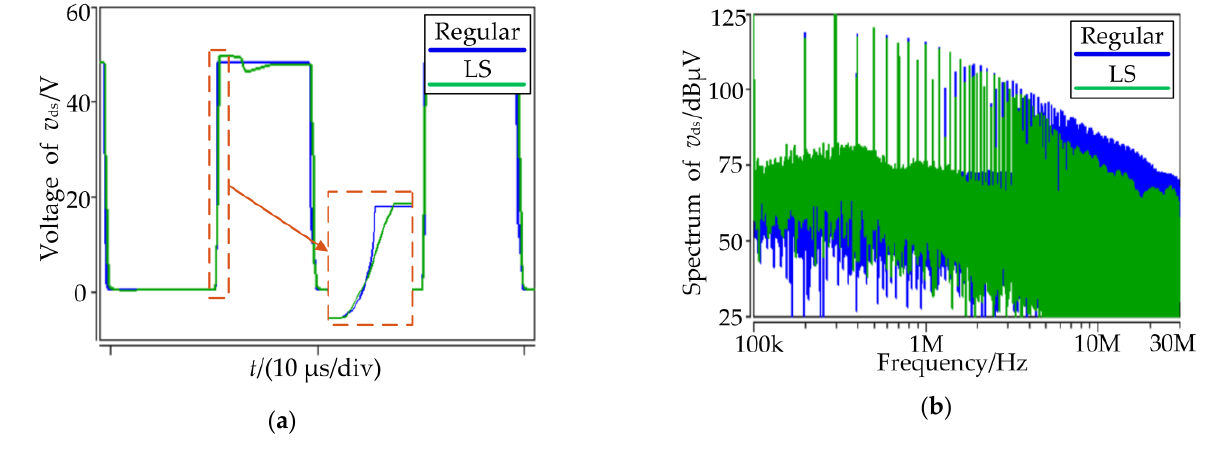
Figure 8. Drain – source voltage waveforms under regular and lossless snubbers: ( a ) Drain – source Figure 8. Drain–source voltage waveforms under regular and lossless snubbers: ( a ) Drain–source voltage waveform and ( b ) Drain – source voltage spectrum. voltage waveform and ( b ) Drain–source voltage spectrum.